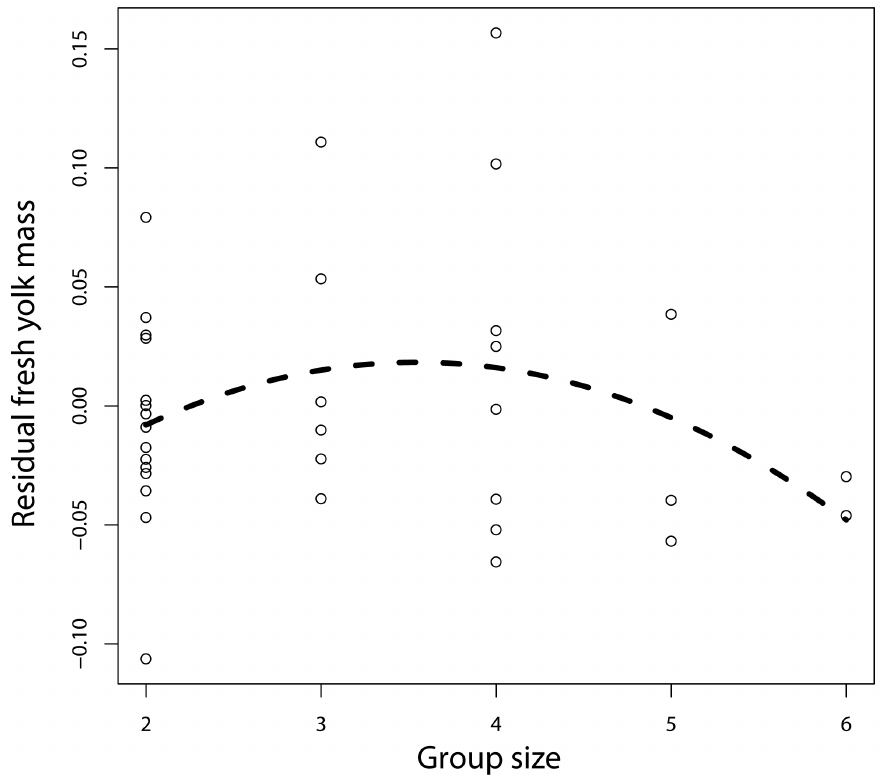
pairs (Fig. 3). Testosterone concentration tended to decrease with clutch size but this was below the significance threshold (Table 4). There were no effects of egg mass, yolk mass, the number of breeding attempts, colony size and rainfall (Table 4).